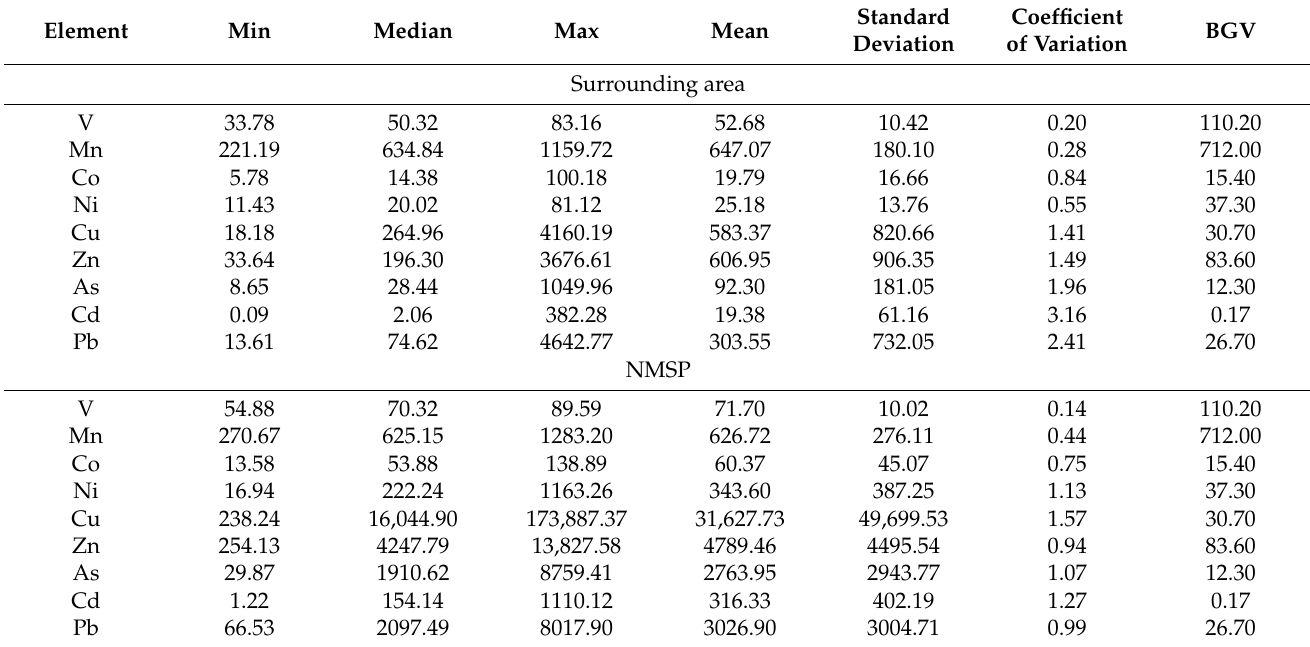
Table 1. Descriptive statistics of heavy metals in soils of the surrounding area and non-ferrous metal smelting plant